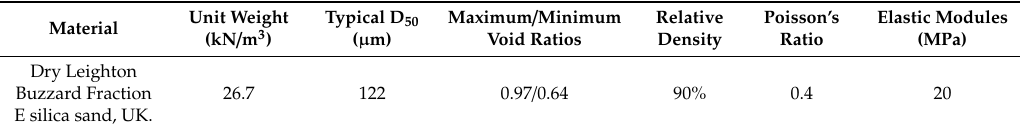
Table 1. Physical parameters of soil samples.